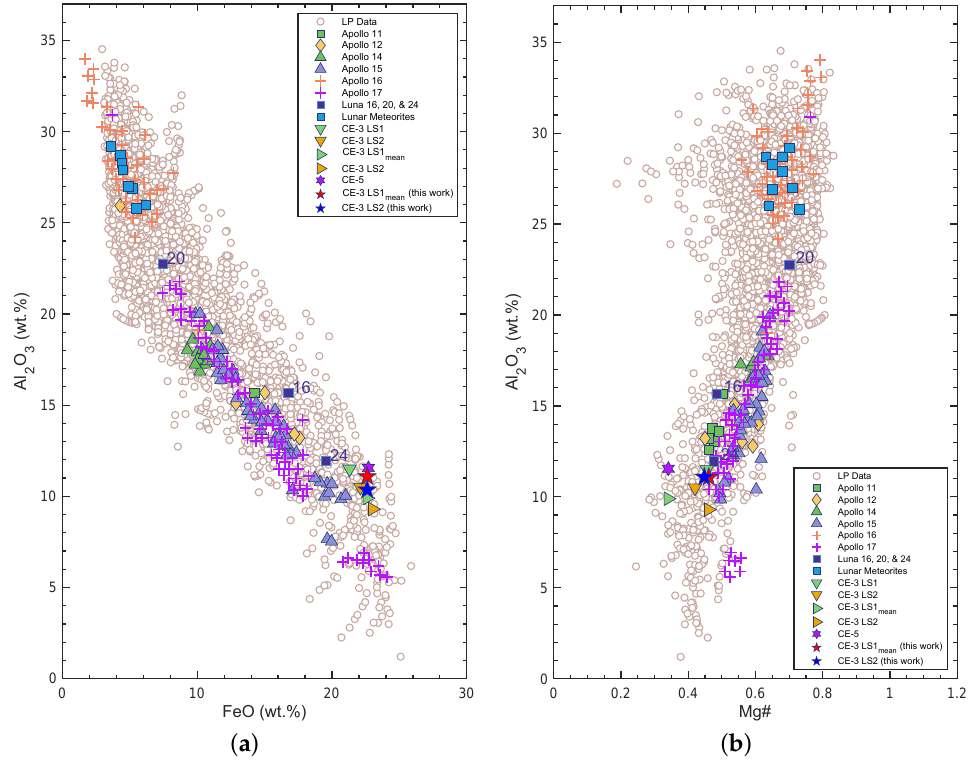
Figure 12. ( a ) Scatter plot of Al 2 O 3 versus FeO. ( b ) Scatter plot of Al 2 O 3 versus Mg# (molar Mg The elemental abundance data derived from gamma-ray spectrometer (GRS) of Lunar Prospector (LP) are plotted [10,12], which were binned onto a map with 5 ◦ . The compositional data of sample soil and regolith breccias (<1 cm-diameter) from each Apollo mission is plotted (cf. Haskin and Warren, 1991 [47]). Also, for the Luna missions, a single point for each mission is plotted. “Meteorite” points each represent one of the regolith-breccia lunar meteorites [48]. Red and blue star indicate the concentrations of soil samples LS1 mean and LS2 of CE-3, respectively (this study). Green and orange down-pointing triangle indicate the concentrations of soil samples LS1 and LS2 of CE-3, respectively [2]. Green and orange right-pointing triangle indicate the concentrations of soil samples LS1 mean and LS2 of CE-3, respectively [3]. Purple hexagram indicates the concentrations of returned lunar soil sample of CE-5